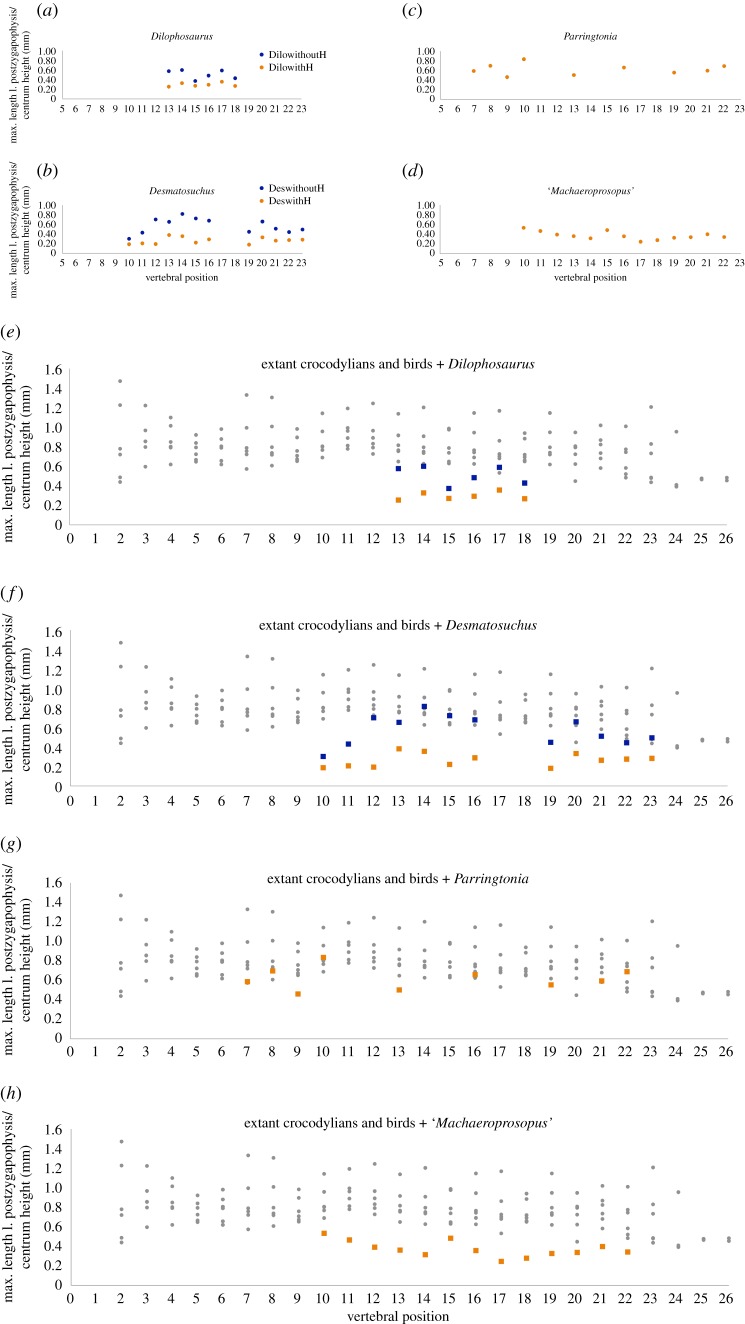
Plots showing the maximum length of postzygapophyseal articulation (proxy for surface area articulating between consecutive vertebrae) corrected for body size along the length of the presacral vertebral columns of four extinct archosaurs, (a) the theropod dinosaur Dilophosaurus wetherilli, (b) the aetosaur Desmatosuchus spurensis, (c) the pseudosuchian archosaur Parringtonia gracilis, and (d) the phytosaur ‘Machaeroprosopus’ zunii. For the plots of two taxa that possess the hyposphene-hypantrum articulation (a,b), we plotted both the maximum postzygapophyseal length divided by centrum height as well as maximum postzygapophyseal length plus maximum hyposphene length divided by centrum height to illustrate the increased relative surface area of articulation when taking into account the articular surface the hyposphene-hypantrum provides. In (e), (f), (g) and (h), the fossil taxa from (a), (b), (c) and (d), respectively, are plotted against the extant taxa data from figure 7 (grey). We notice that for taxa that possess the hyposphene-hypantrum, the more inclusive measurement of articular length (blue data points) plot more closely with the extant data, while the less inclusive measurement (orange data points) plot below the extant data. Extinct taxa that do not have hyposphene-hypantrum articulations plot closely with the extant data.